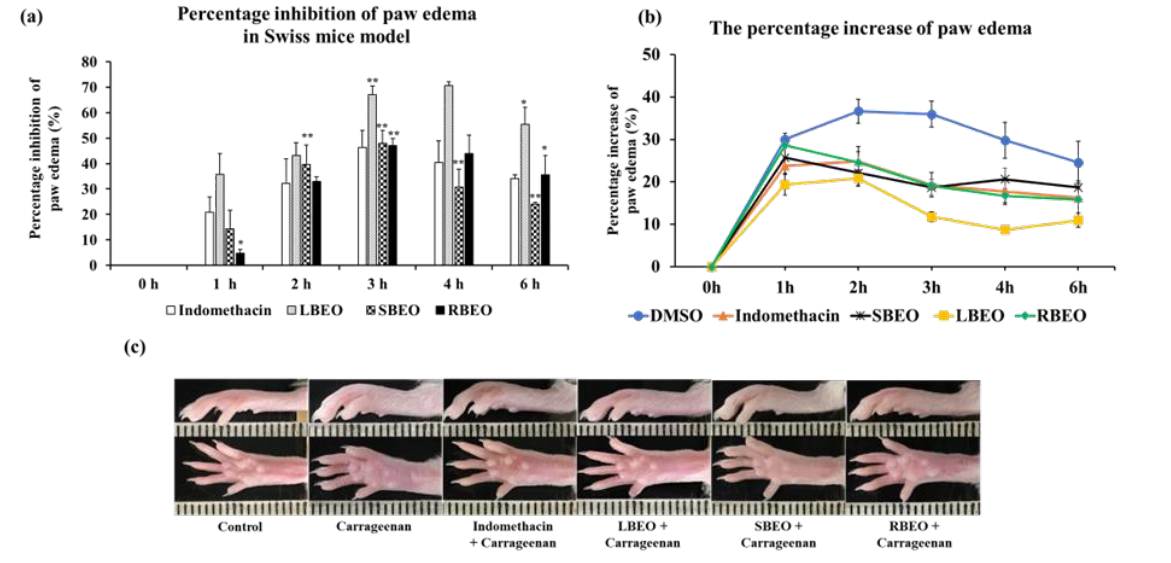
Figure 8. Inhibition of paw edema in mice by LBEO, SBEO, and RBEO. ( a ) The percentage inhibition of paw edema in mice over time was monitored after treatment with LBEO, SBEO, RBEO, and the positive control (indomethacin). Data are shown as mean ± SD ( n = 6 mice/group), * ( p < 0.01), and ** ( p < 0.001) vs. indomethacin group. ( b ) The percentage increase in paw edema. ( c ) Image of hind paws of mice at 3 h after carrageenan injection.